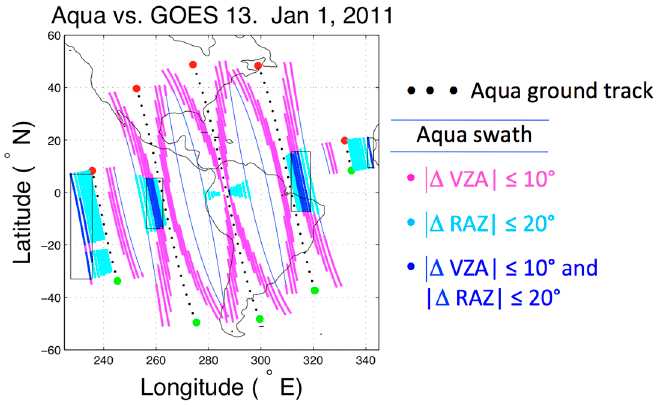
Figure 4. LEO-GEO event prediction, Aqua MODIS vs. GOES-13, 1 January 2011, daytime.